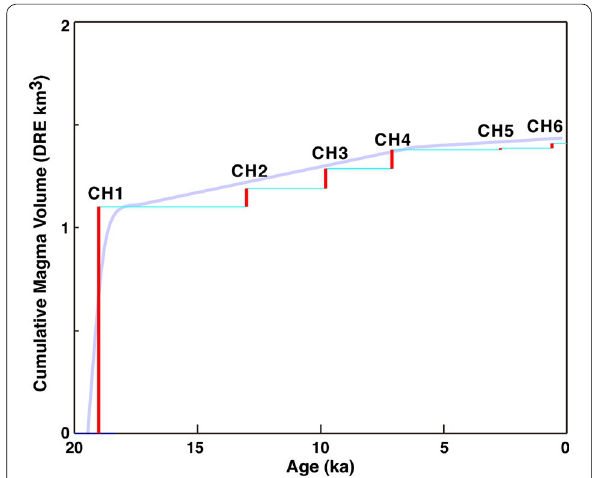
Fig. 14 Cumulative magma volume erupted from Nasu-Chausu- dake Volcano. A red solid line represents an eruption event. A lilac solid line shows a tendency of the eruption rate. CH1 Osawa = unit; CH2 Yumoto unit; CH3 Yahata unit; CH4 Omaru unit; = = = CH5 Minenochaya unit; CH6 1408–1410 unit (Yamamoto 1997) = =